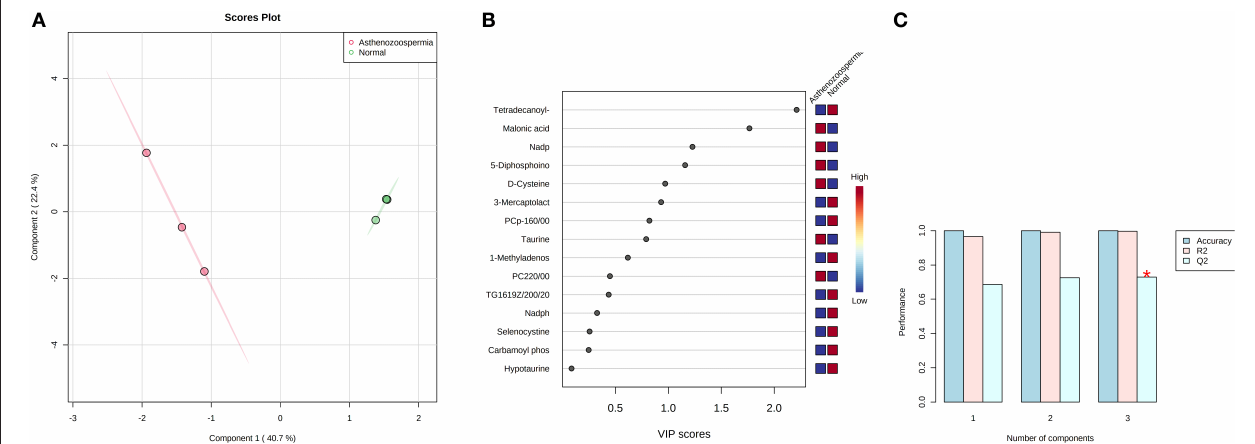
FIGURE 5 | PLS-DA based on score plot (A) and Heat map (B) of Vip score of significant metabolites in seminal plasma of astheno-oligozoospermia bulls. (C) Cross validation of PLS-DA based on score plot of significant metabolites in seminal plasma of astheno-oligozoospermia bulls where Q2 is an estimate of the predictive ability of the model, and is calculated via cross validation. In each CV, the predicted data are compared with the original data, and the sum of squared error is calculated. The prediction error is summed over all samples (Predicted residual sum of squares or PRESS). For convivence, the PRESS is divided by initial sum of the squares and subtracted from 1 to resemble the scale of the R2. Good prediction will have low PRESS or high Q2. It is also possible to have negative Q2, which means that the model is not at all predictive or overfitted.